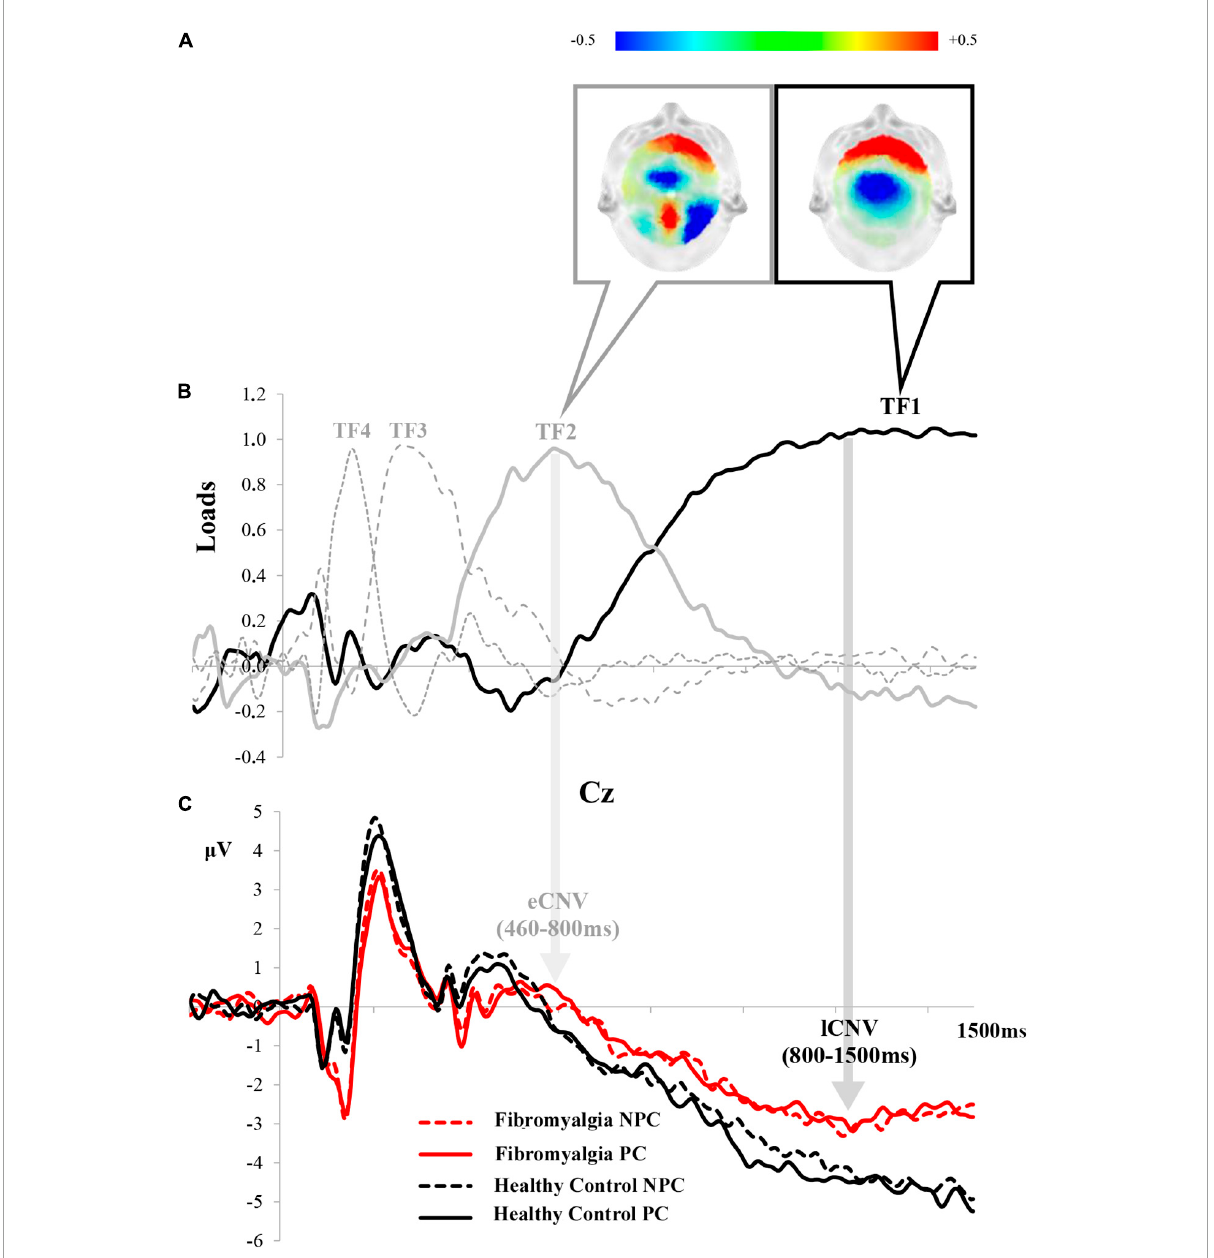
FIGURE2 Correspondence between TFs and ERP components derived from the tPCA in the expectation period: (A) topographical distribution of early (TF2) and late (TF1) CNV; (B) TF loads after the application of tPCA; and (C) the correspondence of each component in the grand average of Cz. (PC, pain cue; NPC, no pain